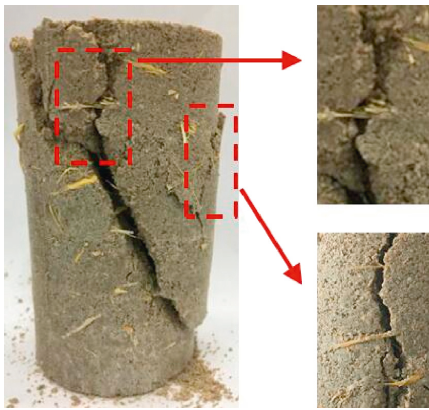
Figure 7: “Bridge” effect of wheat straw in cemented soil.